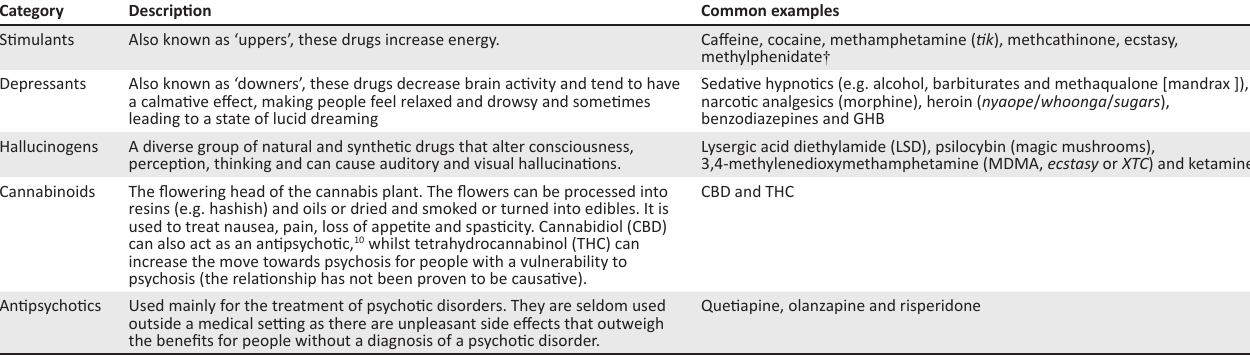
TABLE 2: Overview of common drug types .